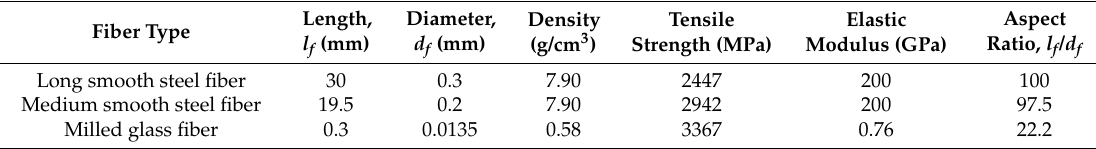
Table 2. Properties of fibers.